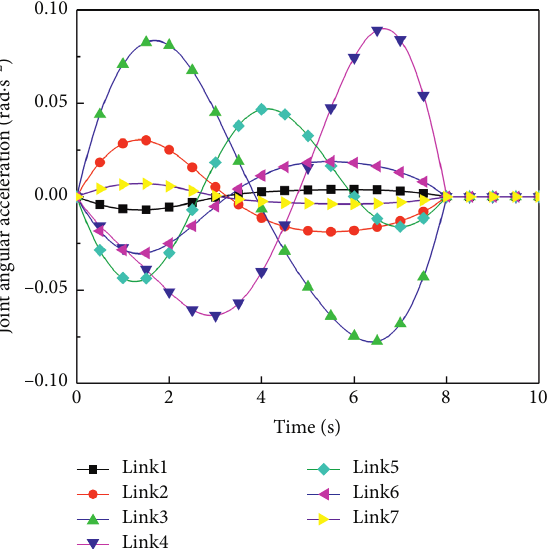
Figure 5: Planning joint angles (rad).